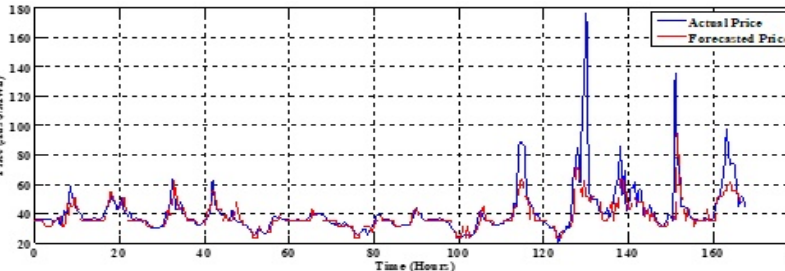
Figure 3. July 8–14, 2015 forecasting without feature selection (MAPE = 11.72).